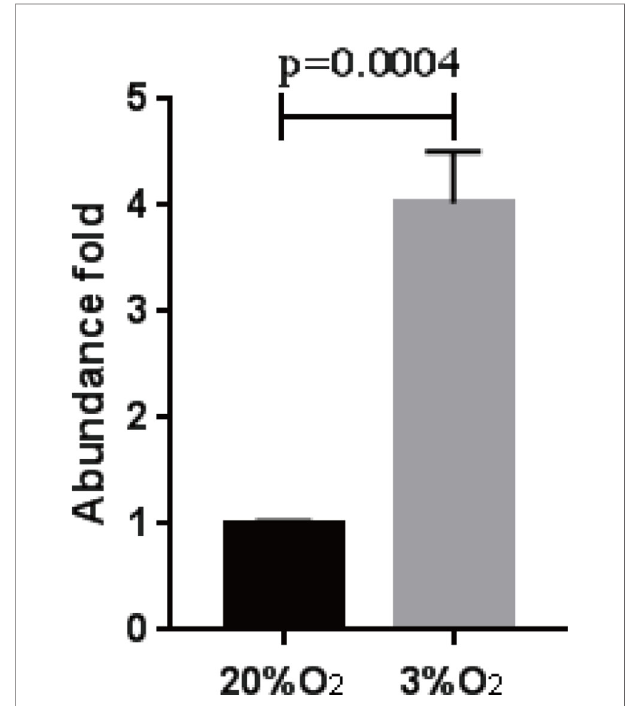
FIGURE 6 | B. bigemina LDH abundance in different oxygen concentrations. B. bigemina was cultured in 20% and 3% oxygen,